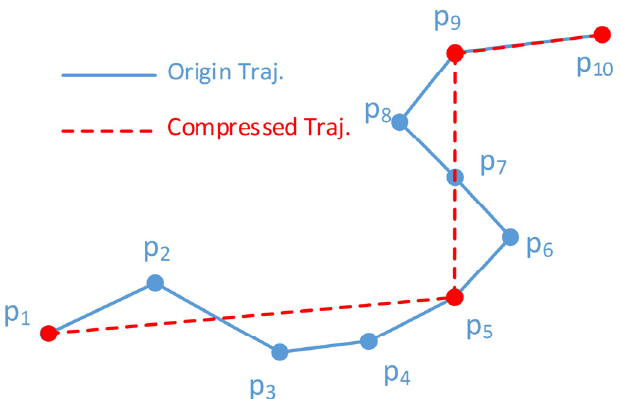
Figure 1. Illustration of trajectory simplification. The original trajectory consists of ten points and the simplified trajectory contains four points, namely { p 1 , p 5 , p 9 , p 10 }